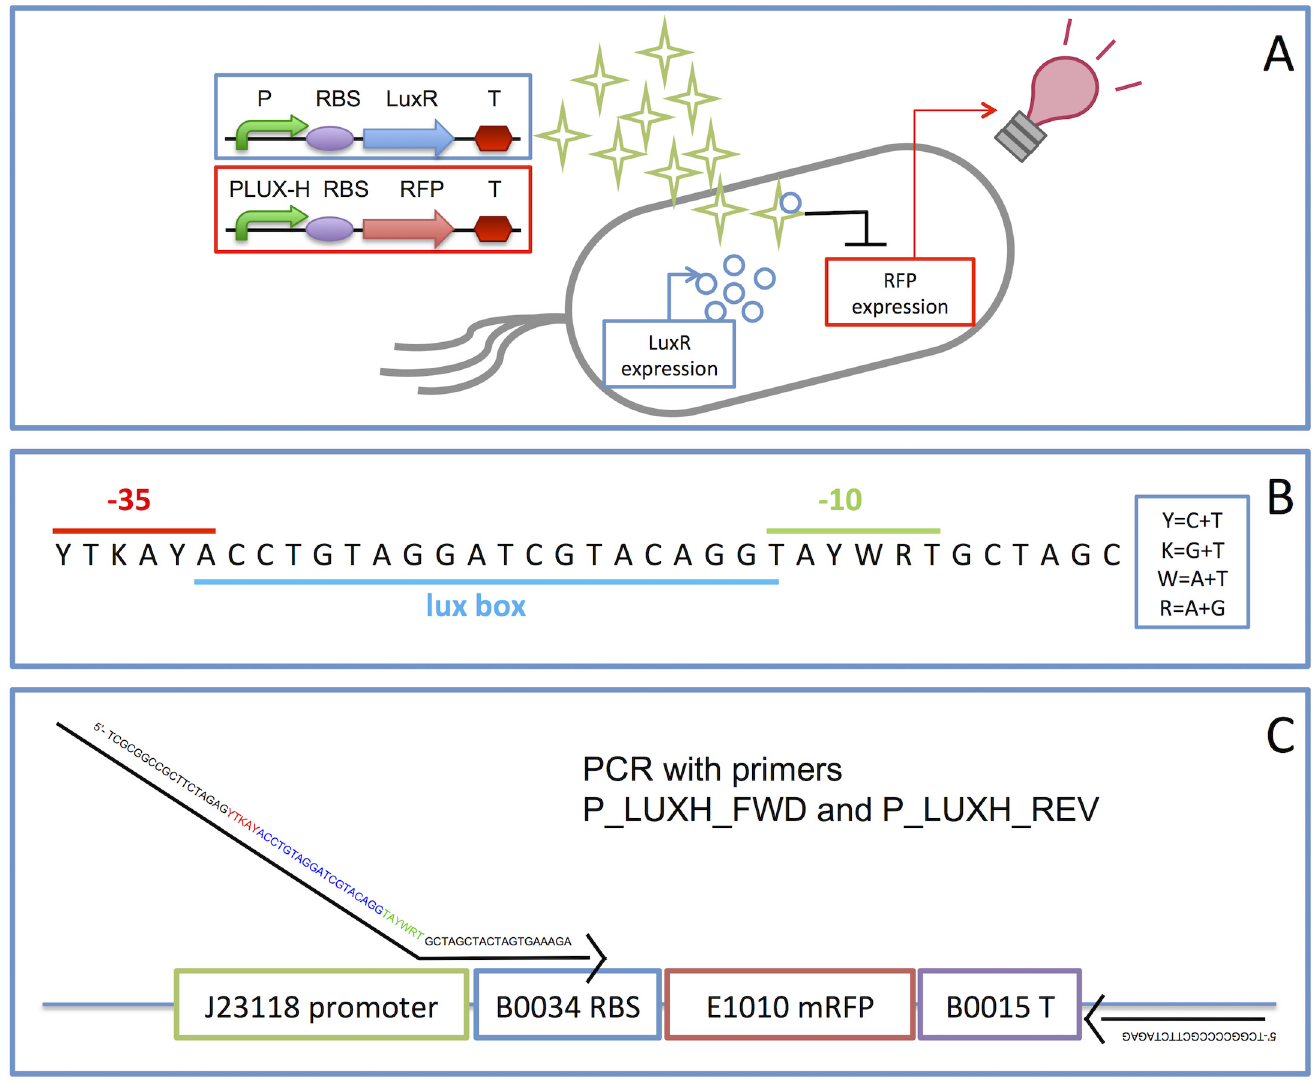
Fig 1. Structure and schematic behaviour of the LuxR-repressible promoters. A) Schematic representation of the working principle of the repressible promoters. In the blue and red boxes the two synthetic networks representing the constitutive LuxR expression cassette and the LuxR-regulated RFP expression cassette are shown, respectively (curved green arrows represent promoters, purple ovals represent RBSs, coloured arrows represent genes and red hexagons represent transcriptional terminators). Green stars represent the AHL inducer molecules, diffusing through cell membrane and binding the LuxR transcription factor (blue circles). This complex represses the expression of RFP. B) The consensus sequence of the library of LuxR-repressible promoters is reported, according to the IUPAC nucleotide code (reported in the box on the right). -35 (red line), -10 (green line) and lux box (blue line) regions are highlighted. C) Generation method of the library via PCR with degenerate primers. The template is BBa_J23118 in the BBa_J61002 plasmid. In every box, the BioBrick code of the corresponding part is reported. The forward primer P_LUXH_FWD anneals with the template in a region falling between promoter and RBS and has a floating tail containing the degenerate sequence (the -35, lux box and -10 regions are highlighted in red, blue and green, respectively), while the reverse primer P_LUXH_REV anneals with the sequence downstream of the transcriptional